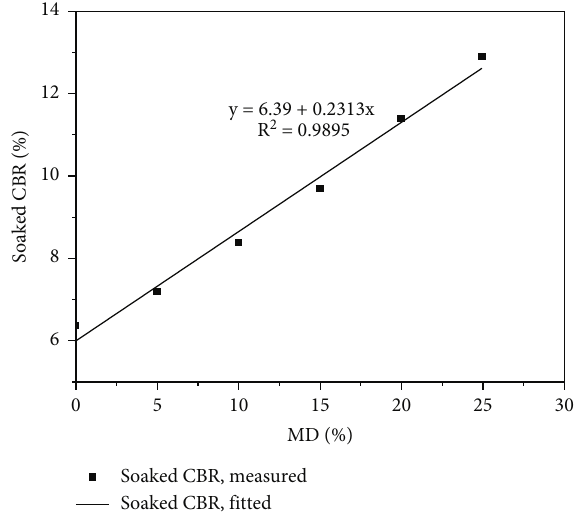
Figure 14: Variation of swelling potential with different per- centages of